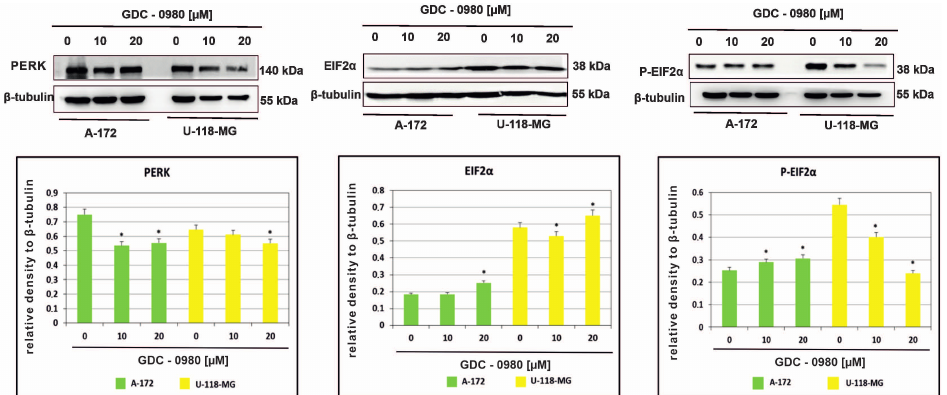
Figure 6. Western blot analysis demonstrates the effect of 48 h GDC-0980 treatment on the expression of PERK, EiF2 α , and P-EiF2 α Ser51 in A-172 and U-118 MG glioblastoma cells, using β -tubulin as a protein-loading control. Samples containing 20 µ g of protein were submitted to electrophoresis and immunoblotting. The representative bands of the PERK, EiF2 α , and P-EiF2 α Ser51 to β -tubulin are illustrated. Data are presented as the means ± SEM. * p <